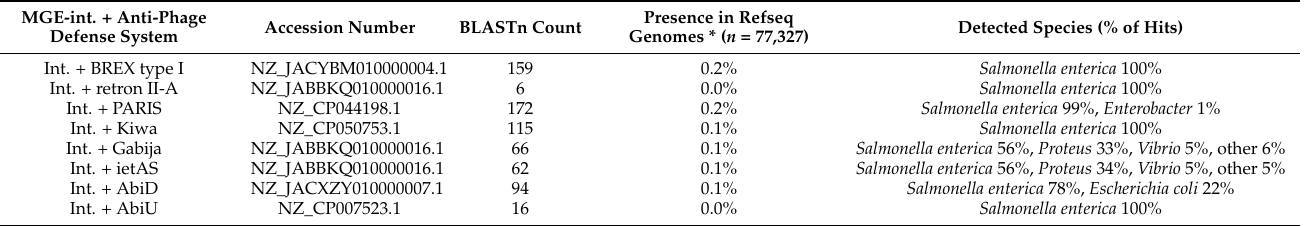
Table 3. Presence of both integrases and reference anti-phage defense systems in non- S.